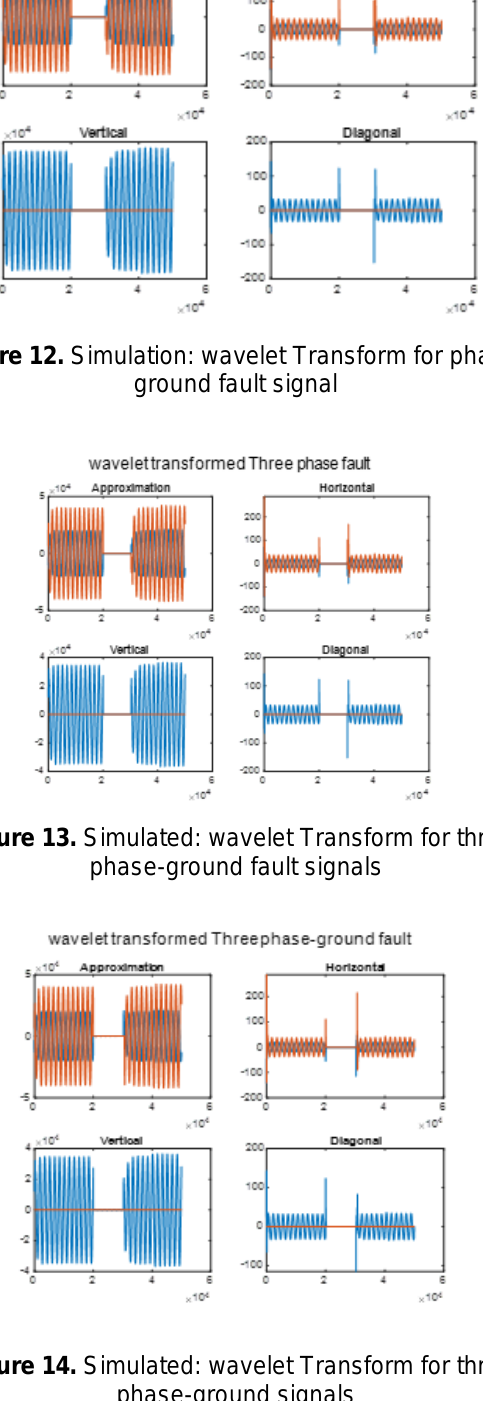
Figure 14. Simulated: wavelet Transform for three phase-ground signals